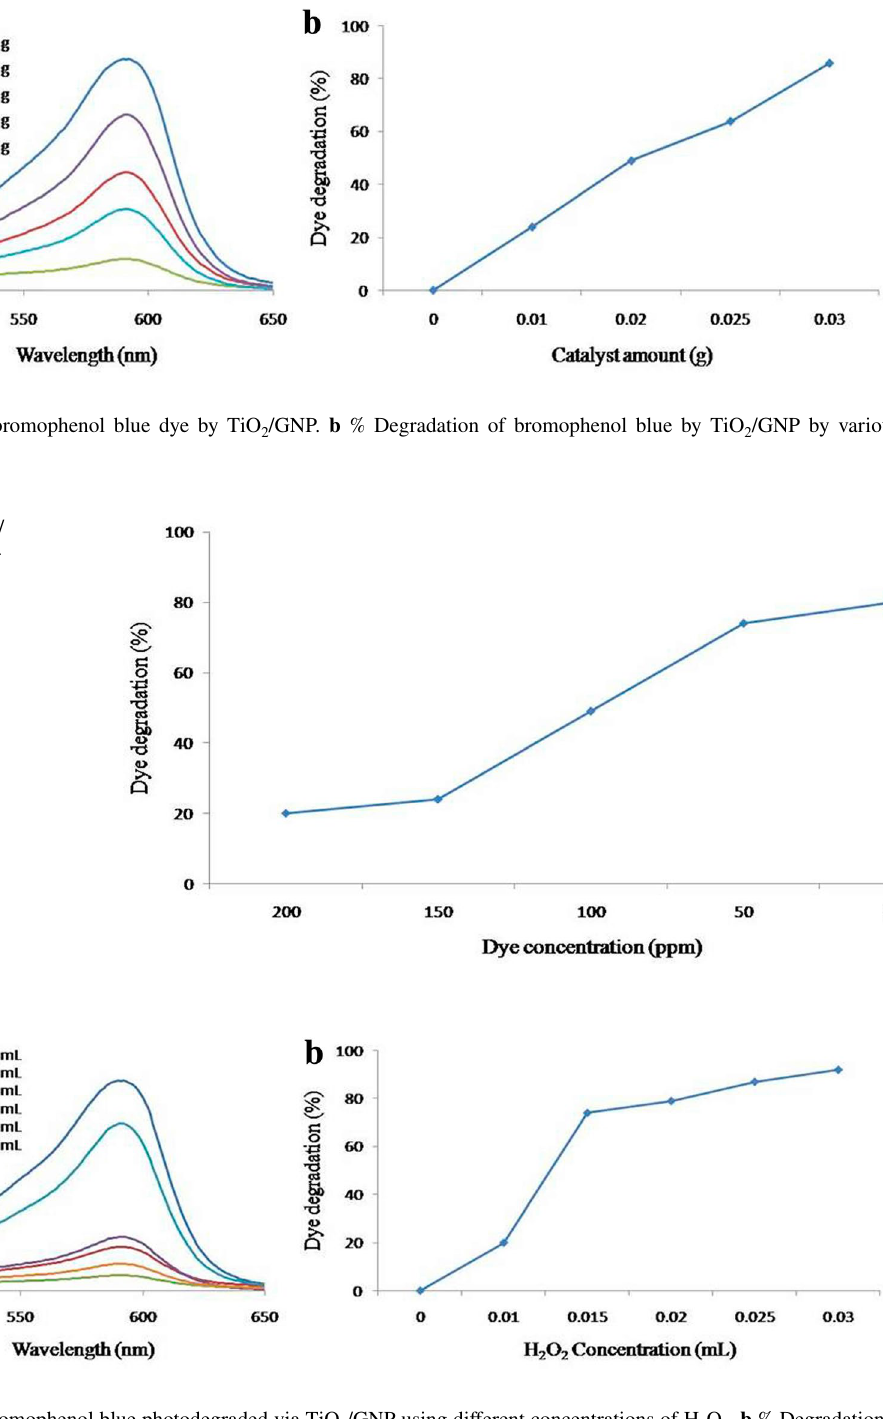
2 /GNP using different concentrations of H 2 O 2 . b % Degradation of MB by